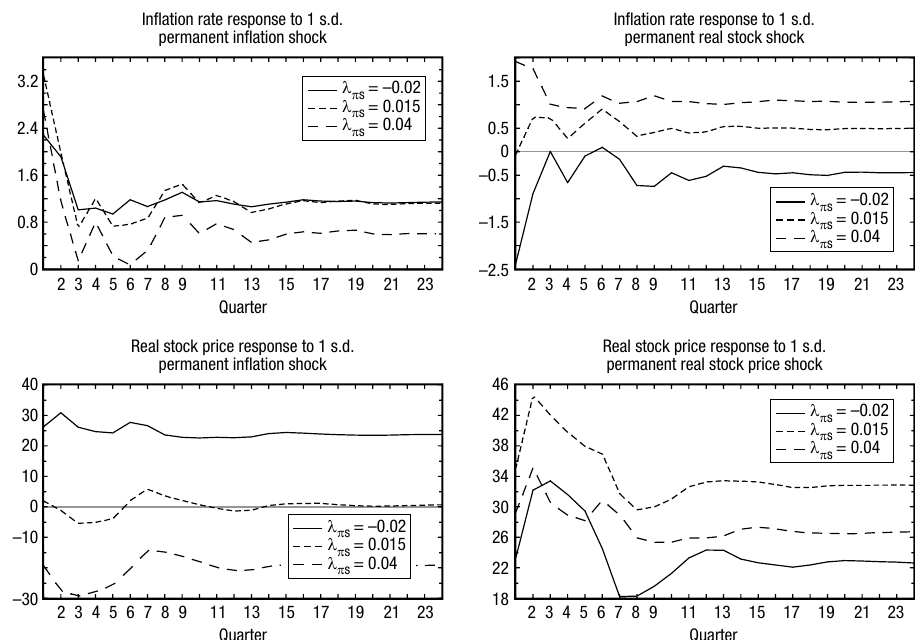
Fig. 4. Inflation and real stock price impulse responses for different assumed g p